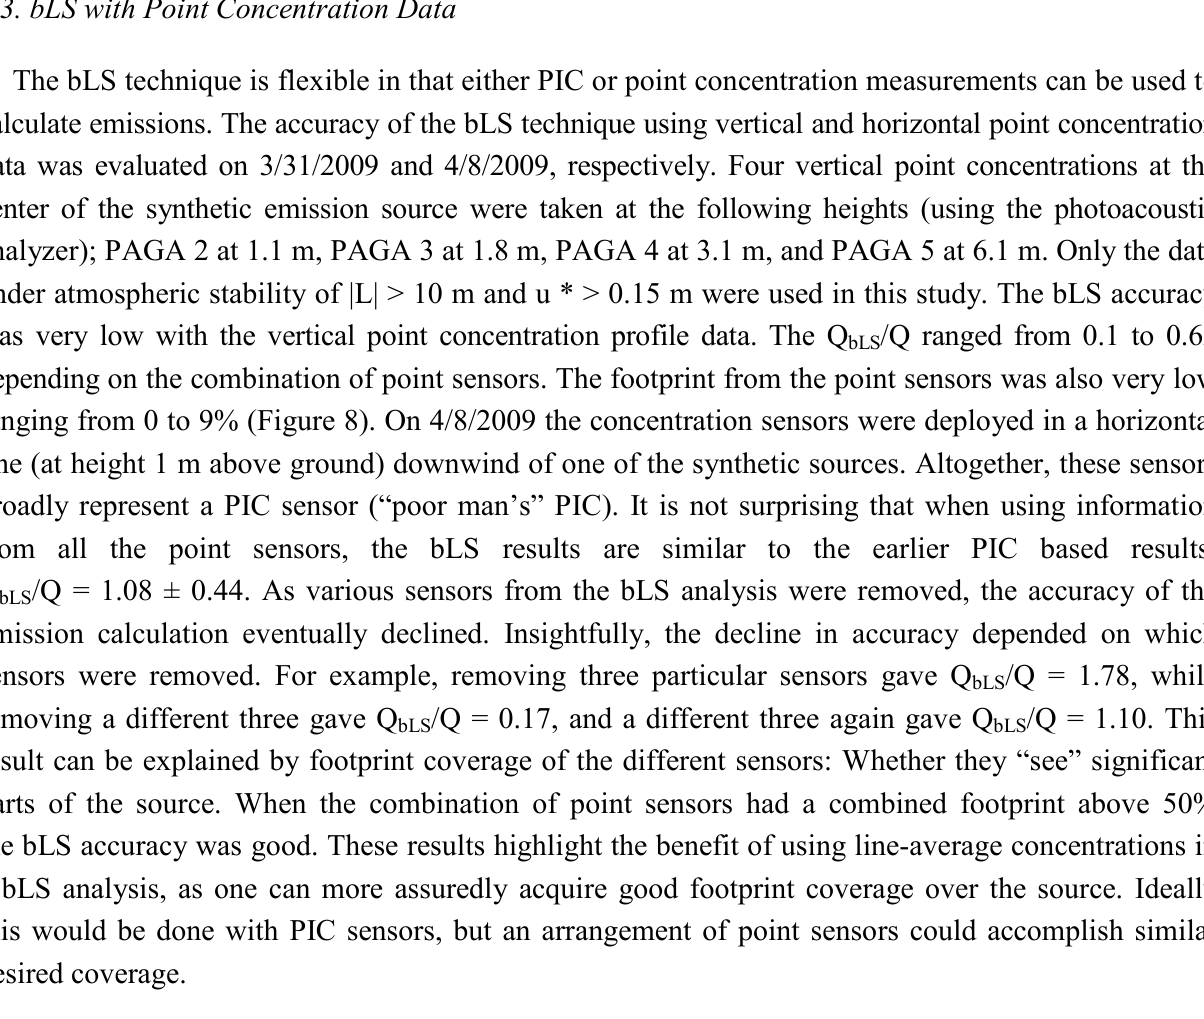
/Q from single source vs. different bLS